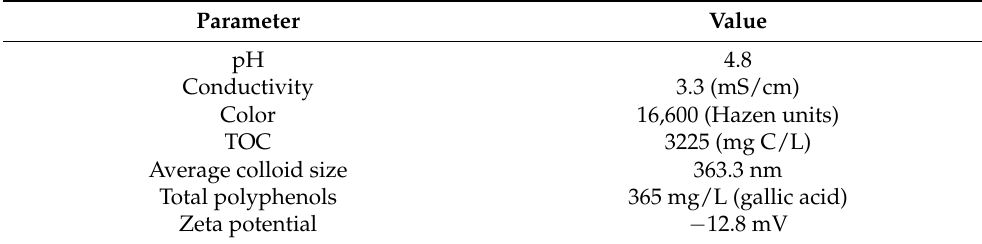
Table 2. Main physicochemical characteristics of cork processing